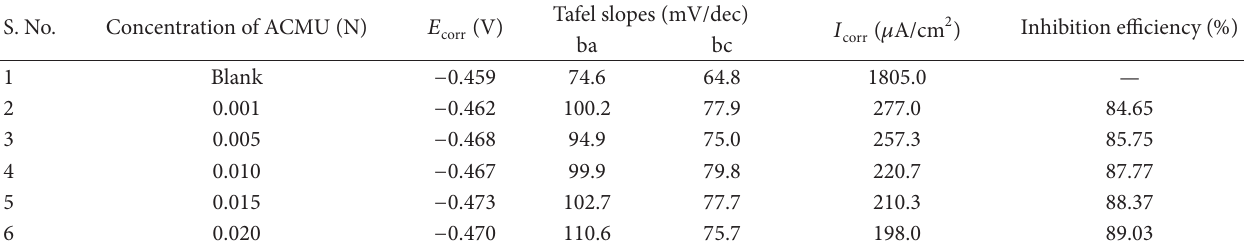
SO with ACMU by potentiodynamic polarisation method. 2 4